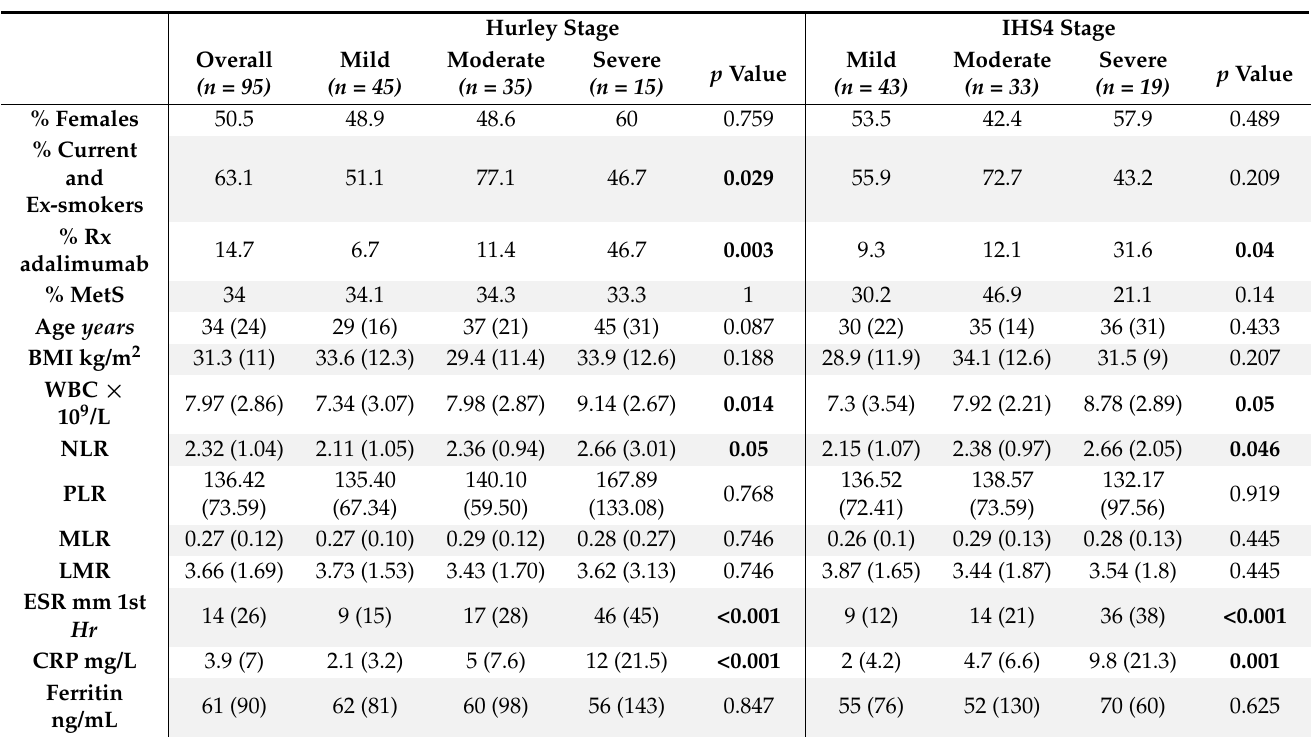
Table 1. The salient clinical and serological characteristics of the study cohort. Data substratified by disease severity as defined by the Hurley and IHS4 classifications are also presented. The median and interquartile ranges (in brackets) are presented for continuous variables. Rx = treatment; MetS = metabolic syndrome ; BMI = body mass index; WBC = white blood count; NLR = neutrophil–lymphocyte ratio; PLR = platelet–lymphocyte ratio; MLR = monocyte–lymphocyte ratio; LMR = lymphocyte–monocyte ratio; ESR = erythrocyte sedimentation rate; CRP = C-reactive protein; IHS4 = International Hidradenitis Suppurativa Severity Scoring System